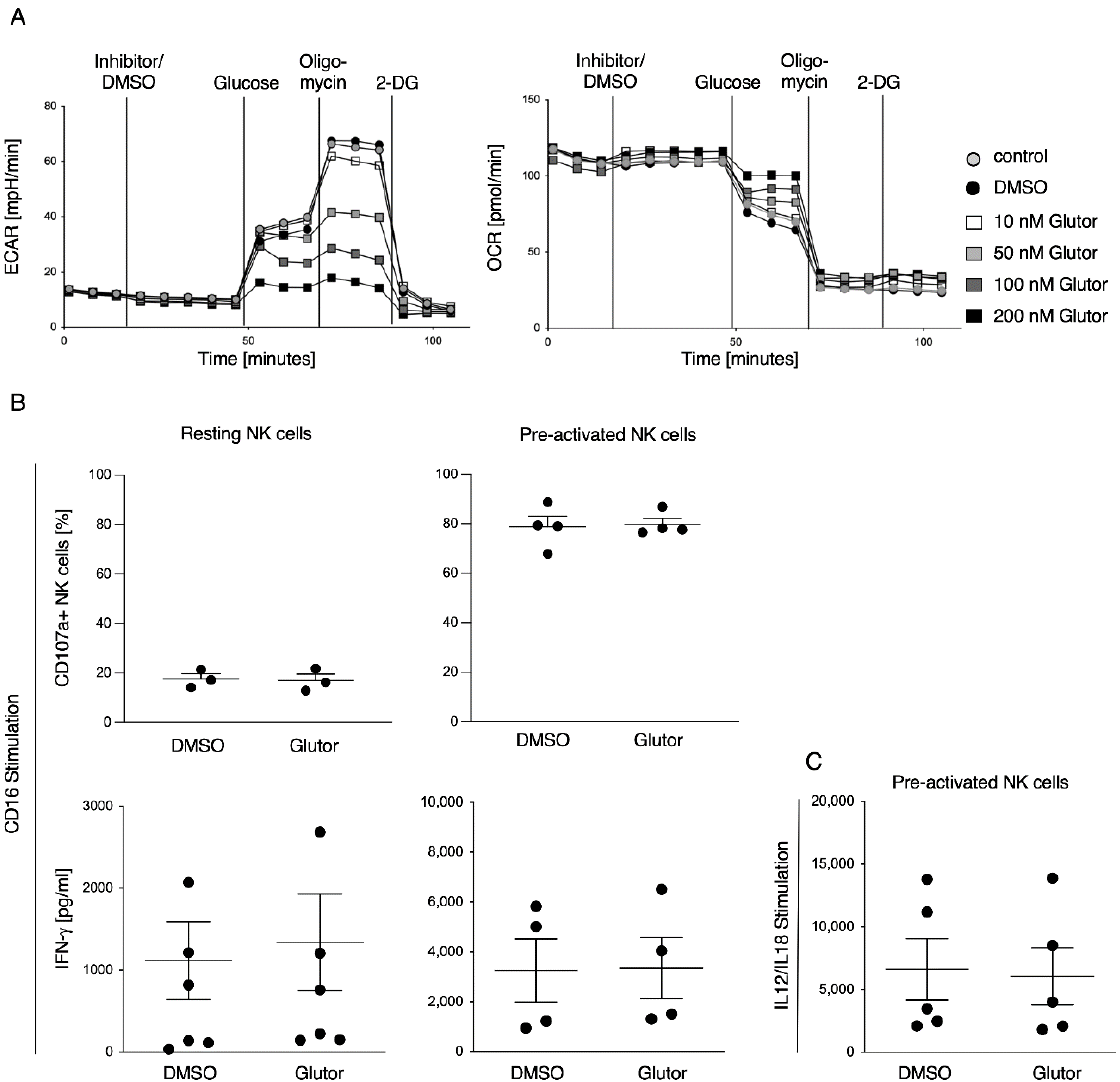
Figure 1. Short-term inhibition of glucose transporters does not affect NK cell functions. ( A ) Rep- resentative image of Seahorse analysis. ECAR levels and OCR levels of pre-activated NK cells before and after injection of medium, DMSO or Glutor (10 nM, 50 nM, 100 nM or 200 nM) followed by injections of glucose, Oligomycin and 2-DG: n = 3. ( B ) Resting NK cells or pre-activated NK cells were pre-treated with 100 nM Glutor or 0.1% DMSO followed by a stimulation via plate-bound CD16-mAb (2 µ g/mL) for 2 h (CD107a assay) or 16 h (IFN- γ ELISA) in the continued presence of Glutor or DMSO: n = 3–6. Data were pooled from three or six independent experiments and each experiment was performed with one donor. Mean with SEM. ( C ) Pre-activated NK cells were pre-treated with 100 nM Glutor or 0.1% DMSO followed by a stimulation via IL-12 and IL-18 for 16 h (IFN- γ ELISA) in the continued presence of Glutor or DMSO: n = 5. Data were pooled from five independent experiments and each experiment was performed with one donor. Mean with